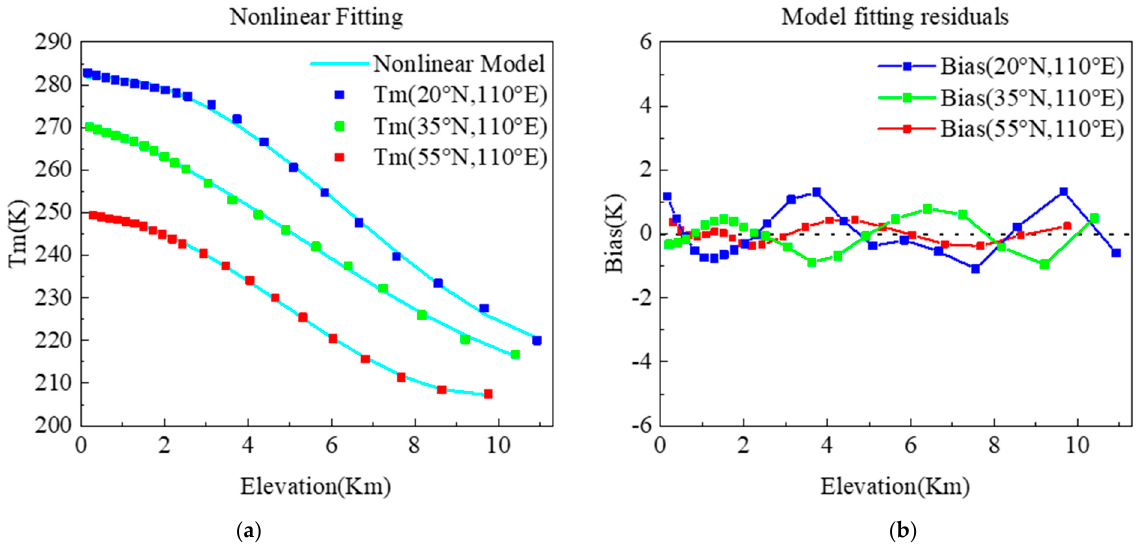
Figure 4. Fitting results ( a ) and residuals ( b ) of the model with nonlinear elevation correction.